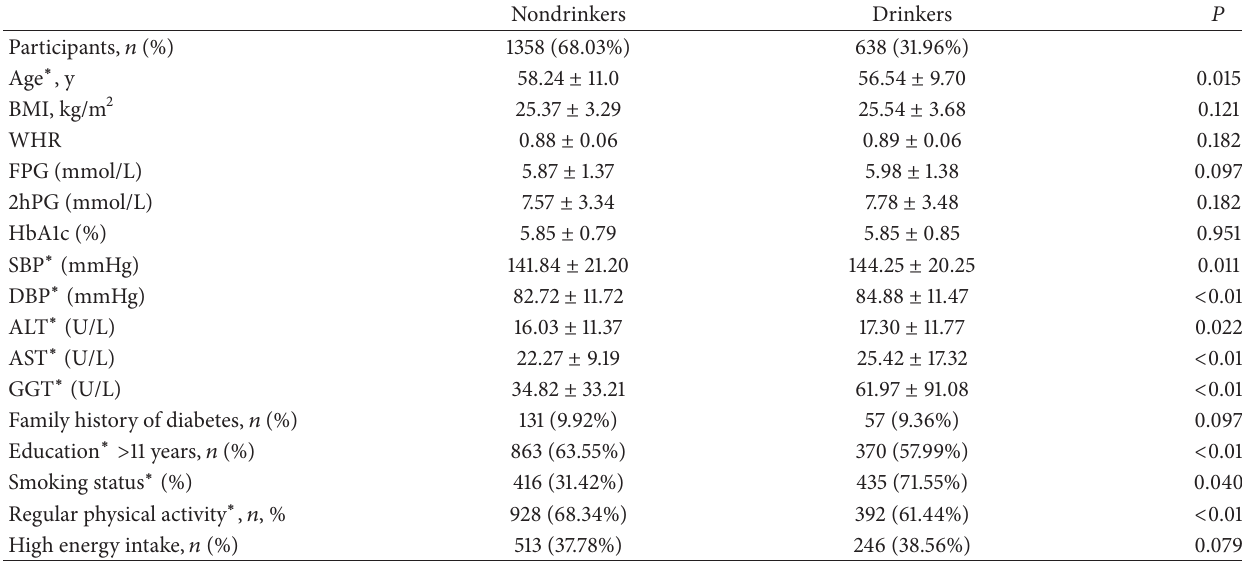
Figure1:(a)Theincidenceofprediabetesanddiabetesingroupofdrinkersandnondrinkers.28.6%and32.8%ofdrinkersshowedprediabetes and diabetes; 13.6% and 16.5% of nondrinkers showed prediabetes and diabetes. (b) The incidence rates of prediabetes and diabetes in the case of none, light, moderate, and heavy alcohol consumption. Table 1: Baseline demographics and characteristics of